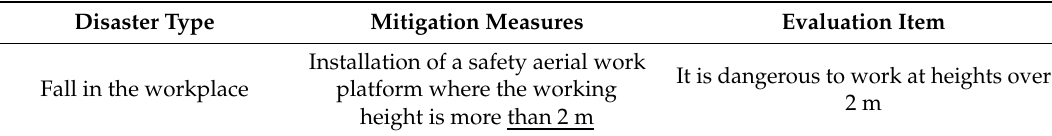
Table 3. Extraction of fall hazard from disaster scenario.